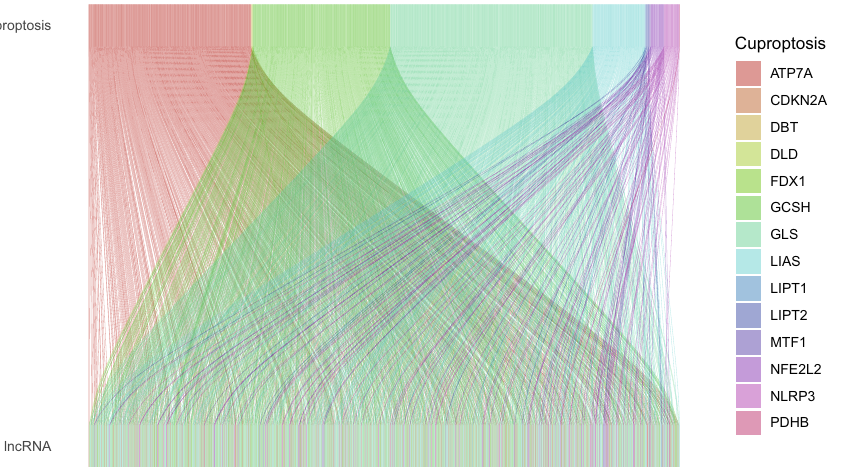
Figure 1. Sankey diagram showing the association between 1138 cuproptosis-related lncRNAs and 19 cuproptosis genes. lncRNA, long non-coding